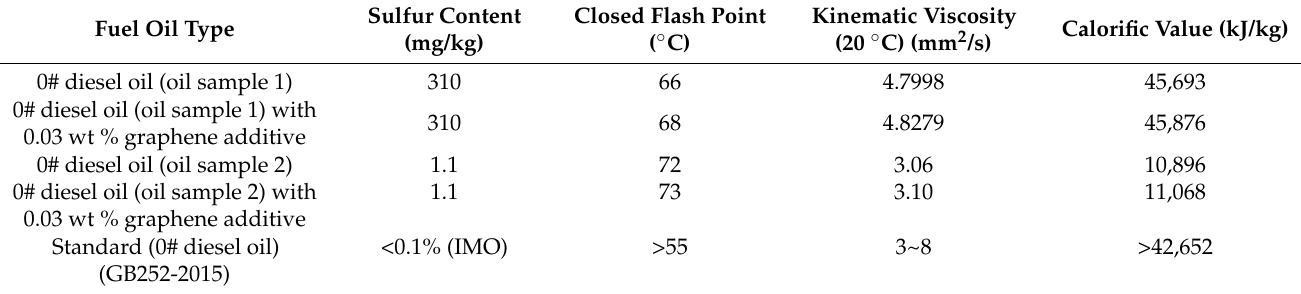
Table 2. Physical and chemical properties of fuel oil samples